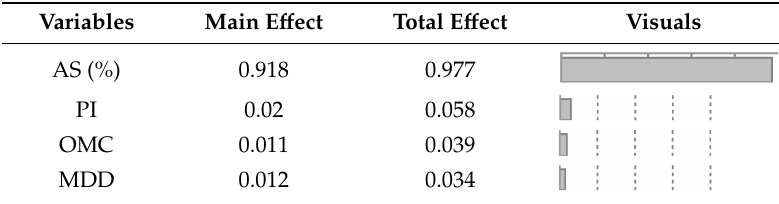
Table 7. Variable Priority